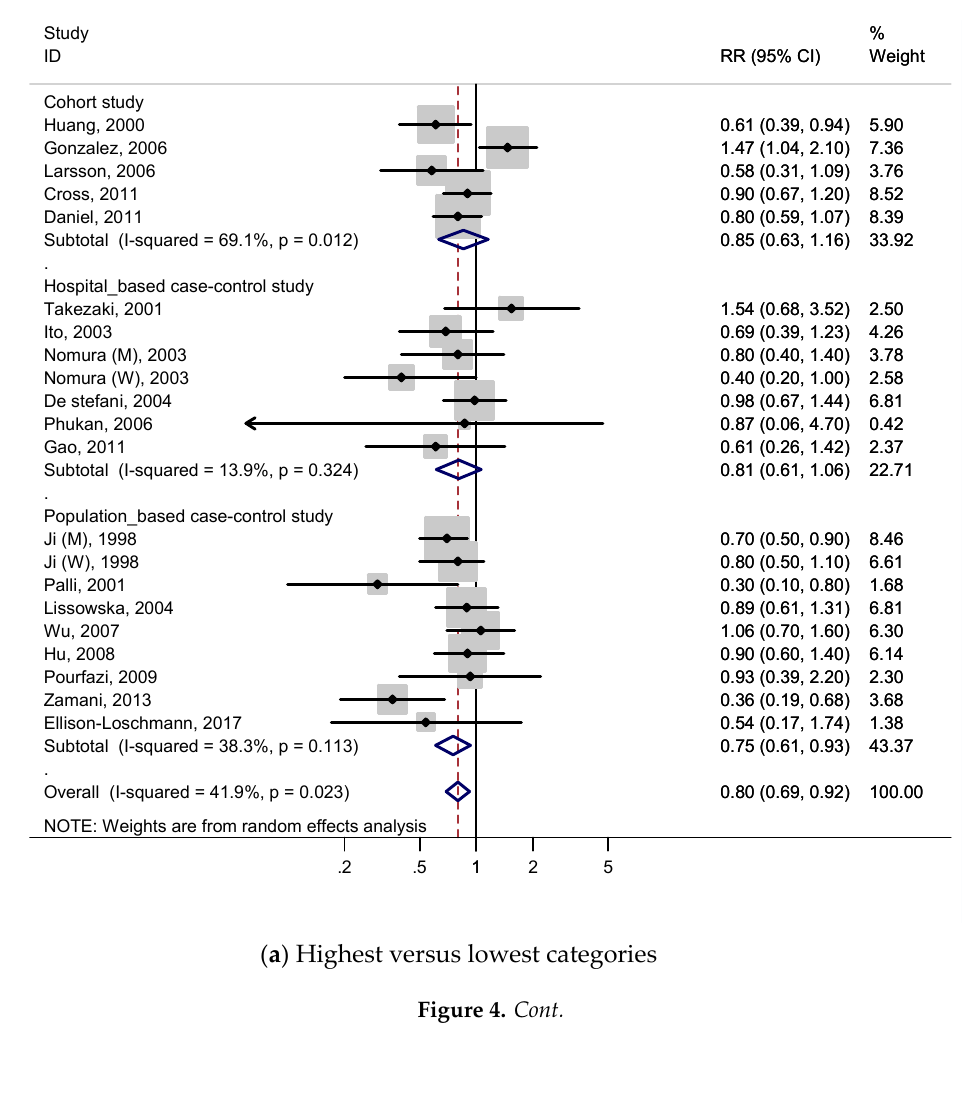
( a ) Highest versus lowest categories Figure 4.